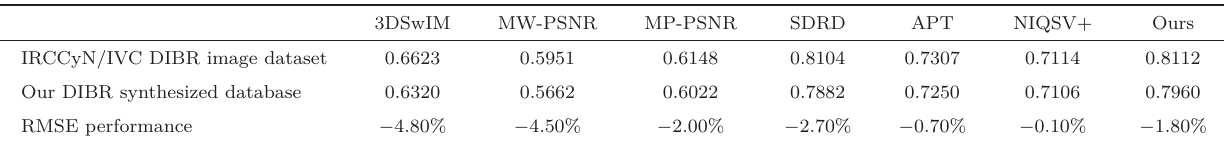
Table 4 RMSE on IRCCyN/IVC DIBR image dataset and testing dataset of our DIBR synthetic image database